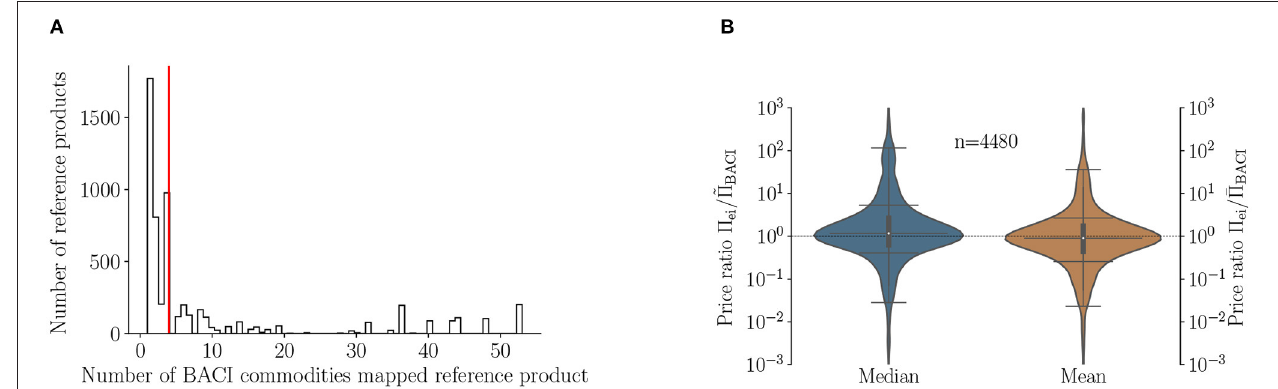
FIGURE 1 | The distribution of the number of BACI (HS12) commodities matched to the reference products of ecoinvent activities (A) . The vertical red line shows the median at four commodities per reference product. (B) Shows the distribution of the ratio of ecoinvent prices 5 ei and the median- ( ˜ 5 BACI ) and mean ( ¯ 5 BACI ) price respectively from the BACI volume weighted price distribution 5 BACI . The horizontal lines in the violins indicated the 2.5, 16, 50, 84, and 97.5% quantiles. The long dashed horizontal line shows a ratio of 1. The number of reference products ( n = 4,480) is smaller than the number of activities/reference products that have a BACI price ( n = 5,624) because not all of these processes have an ecoinvent